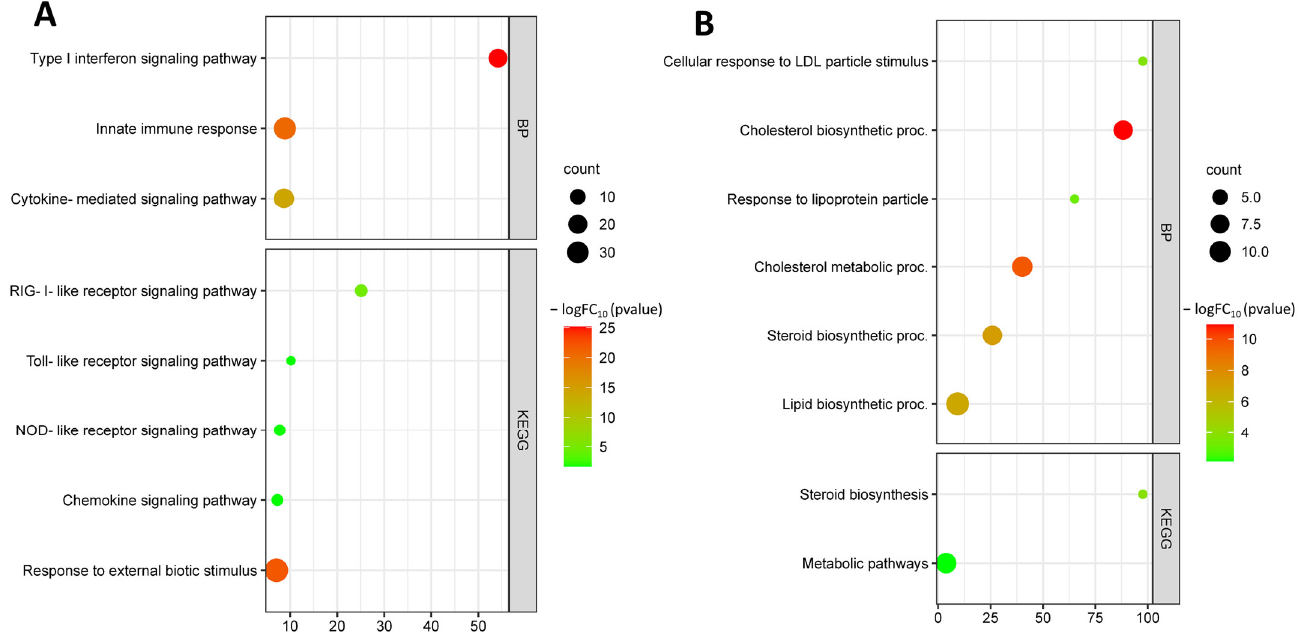
Figure 10. Functional enrichment of up-regulated DEGs of the GSE29881 dataset ( A ); functional enrichment of down-regulated DEGs of the GSE29881 dataset ( B ).